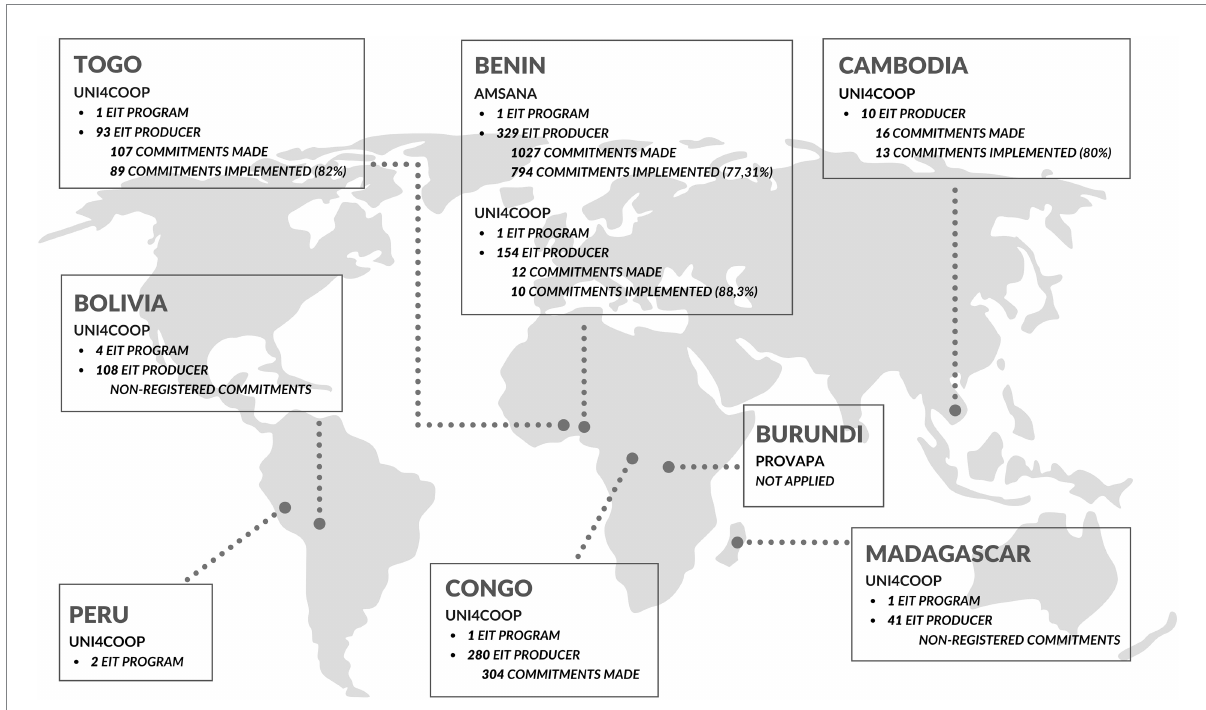
FIGURE 2 Implementation of the EIT approach in the FES program between 2016 and